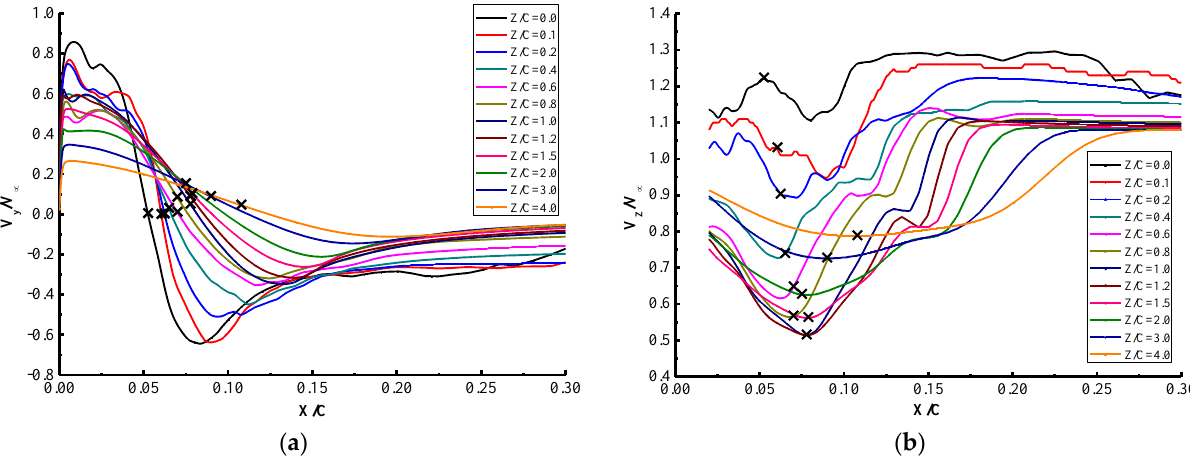
Figure 13. Distribution of velocity component along a horizontal line through vortex core: ( a ) Pitchwise velocity, and ( b ) axial velocity.